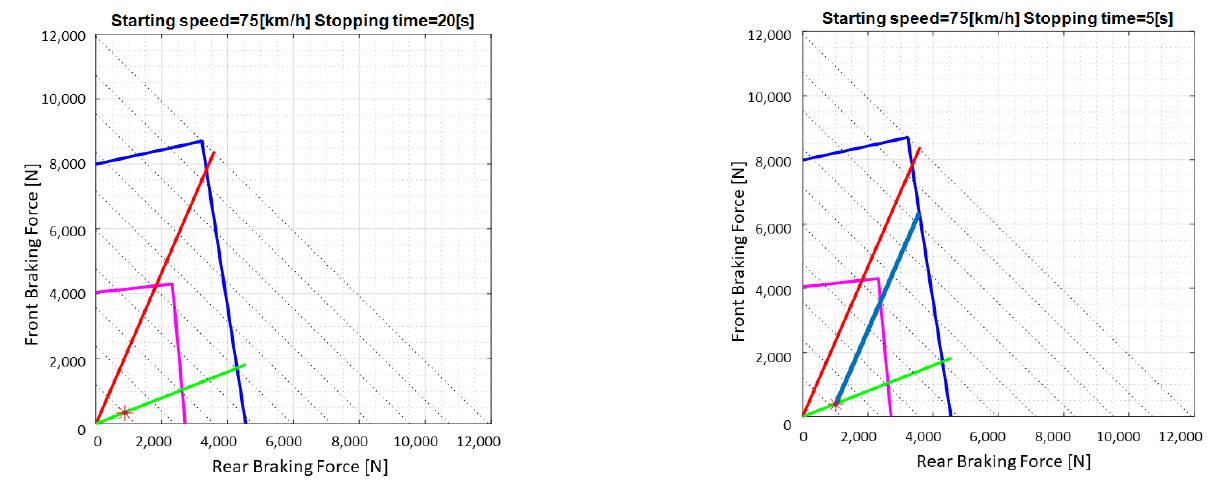
Figure 12. ( Left ) Braking forces (red star) at the best conditions and ( Right ) at the lowest stopping time (starting at red star and then on blue line), both starting at 75 km/h.